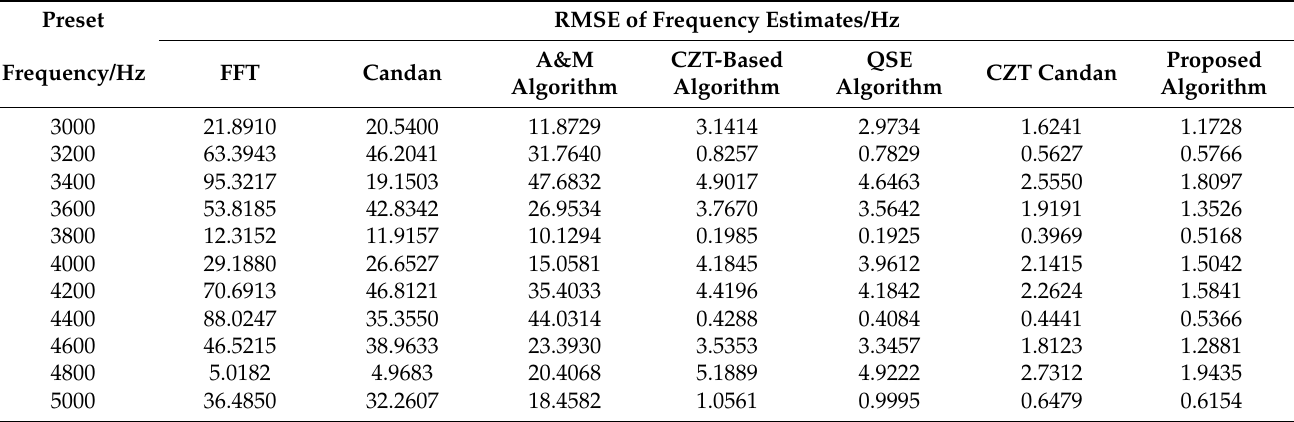
Table 3. RMSEs of the frequency estimates versus the frequency when the SNR is 10